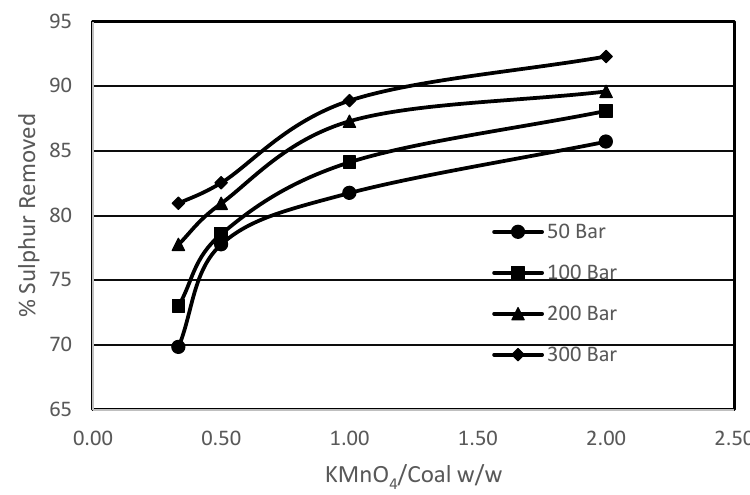
Figure 2. Effect of KMnO 4 /Coal ratio on pyritic sulphur removal.